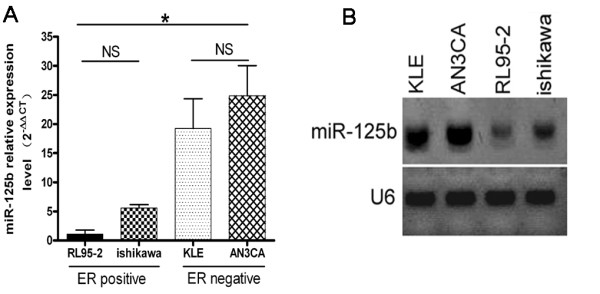
Expression of miR-125b were assessed in EC cells by qRT-PCR and Northern blotting. A. Differential expression of miR-125b between type I and type II EC cells. Bars show mean ± SD. All experiments were repeated three times. *P < 0.01 vs. ishikawa, KLE, AN3CA. B. The results of Northern blotting show that the hybridized signal of the mature miR-125b in EC cells with ER negative was stronger than that in EC cells with ER positive.